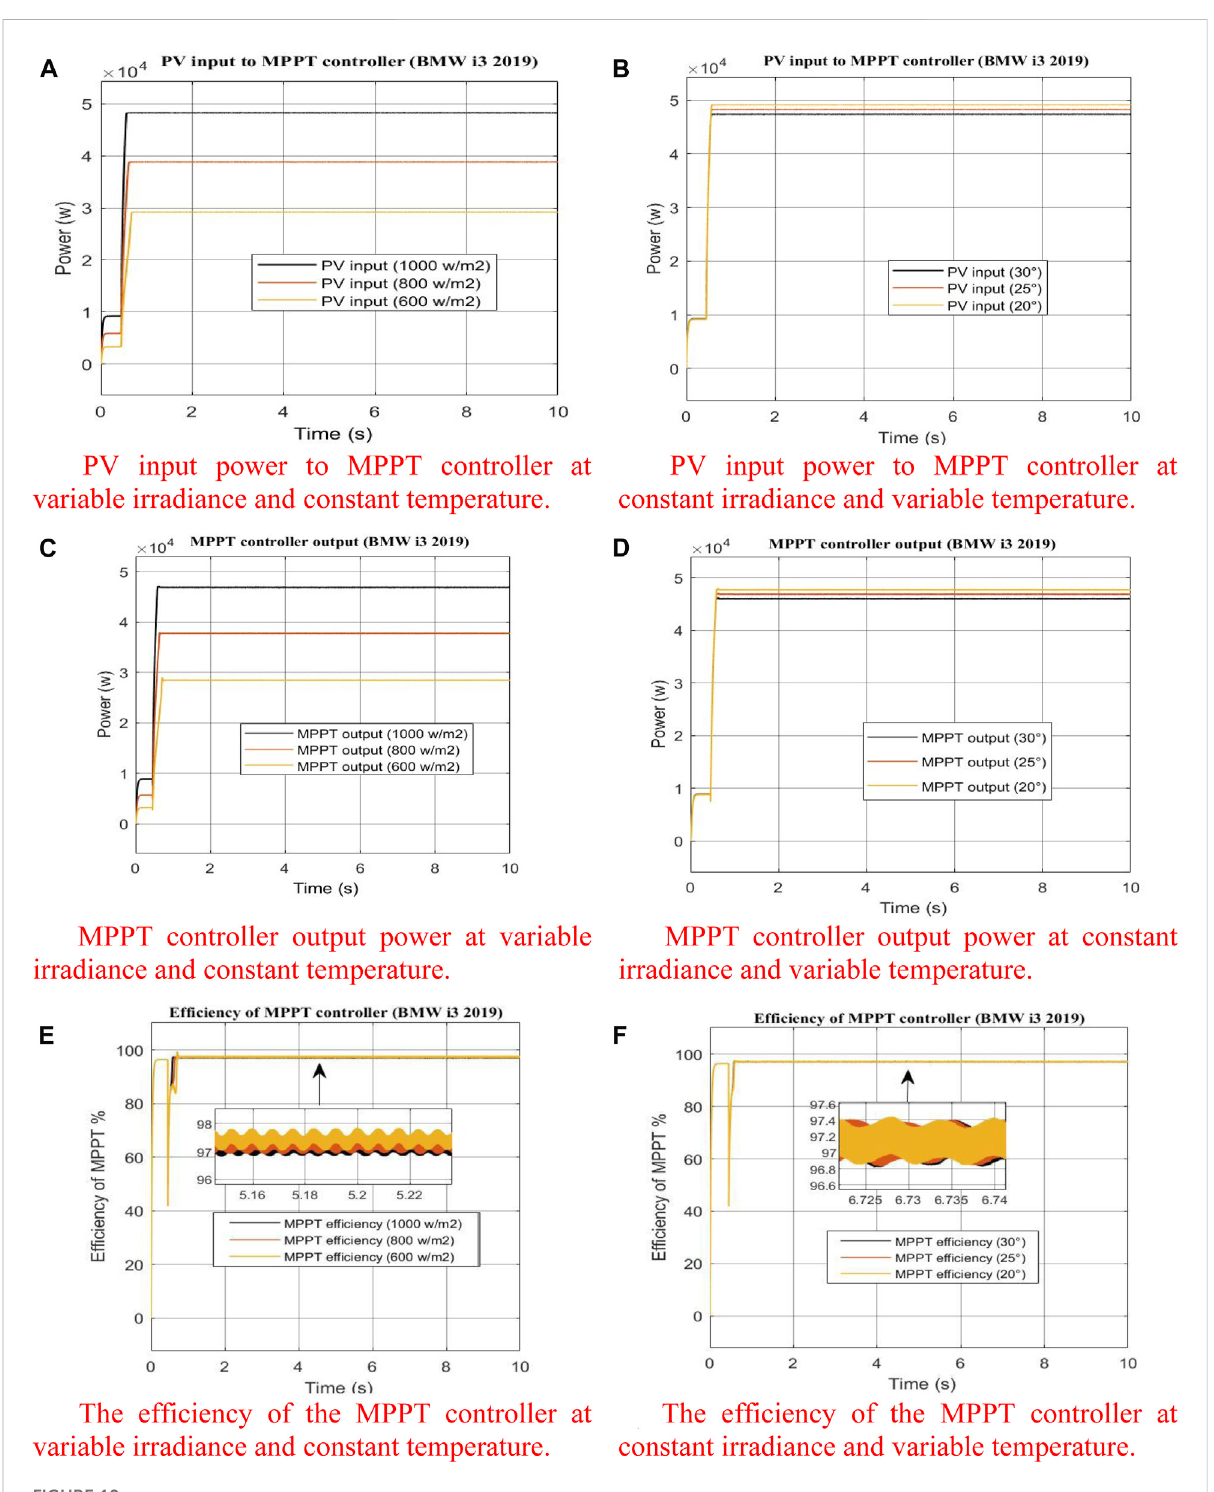
FIGURE 10 Simulation results of the MPPT controller for BMW i3 2019. (A) PV input power to MPPT controller at variable irradiance and constant temperature. (B) PV input power to MPPT controller at constant irradiance and variable temperature. (C) MPPT controller output power at variable irradiance and constant temperature. (D) MPPT controller output power at constant irradiance and variable temperature. (E) Ef fi ciency of the MPPT controlleratvariableirradianceandconstanttemperature. (F) Ef fi